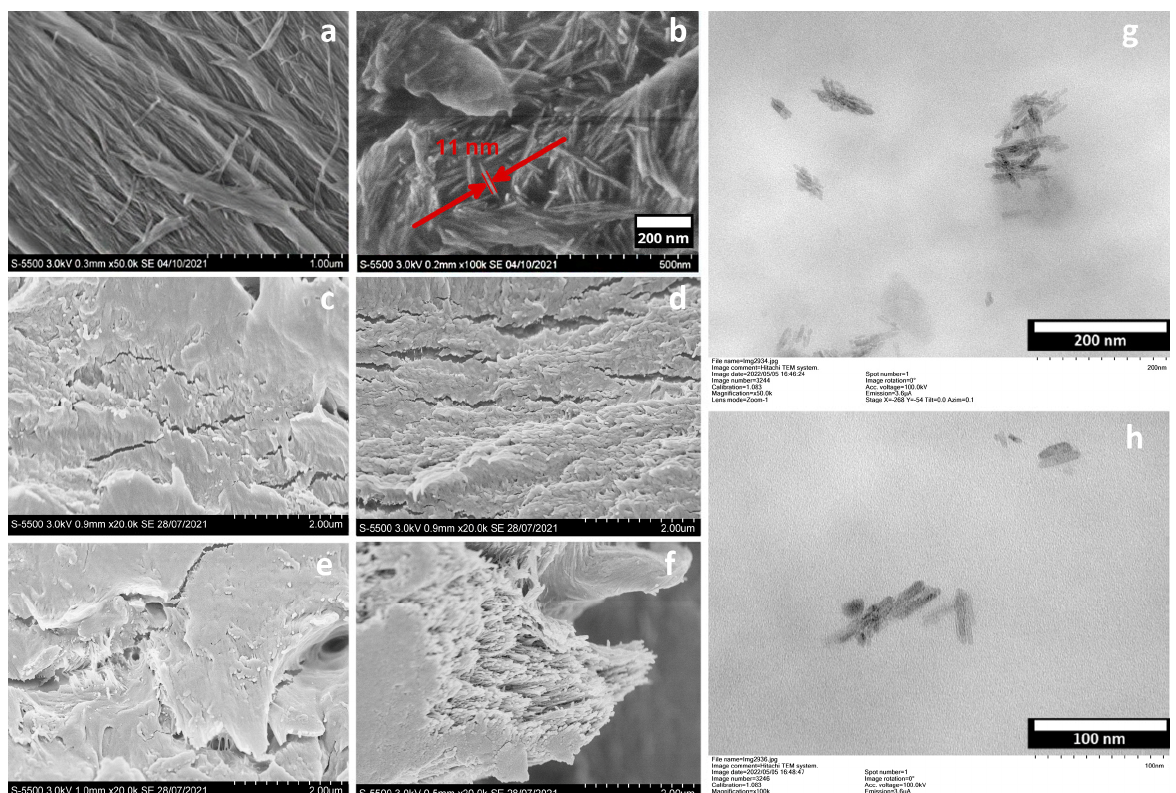
Figure 1. SEM images of AONF ( a ) and cross-sections of PLA ( b ) and PLA/AONF films with different content of AONF: ( c )—0.1%, ( d )—0.2%, ( e )—0.5%, ( f )—1%. TEM Images: ( g , h )—PLA/AONF 1%.